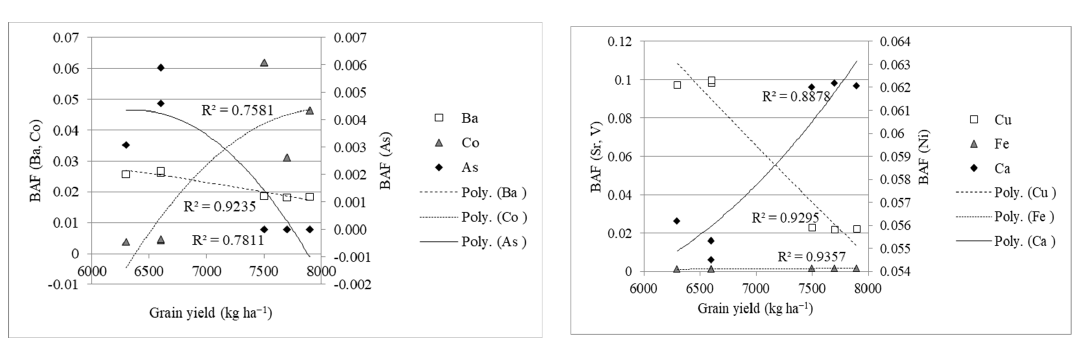
Figure A1. Interdependence (regression analysis) between grain yield and bioaccumulation factor (BAF) in wheat grain from intensive cropping system (ICS).